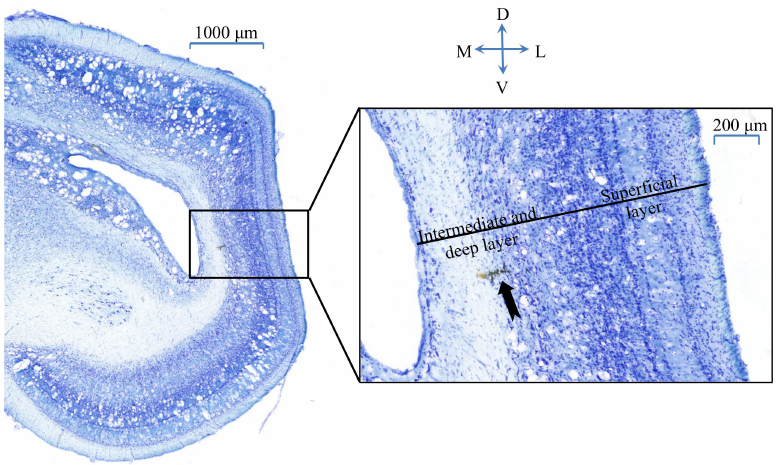
Figure 2. Representative photomicrograph of Nissl-stained coronal section showing the recording site of a sample unit. The right panel showed an enlarged view of the boxed area in the left panel. The black arrow pointed to the recording site. M—Medial; L—Lateral; D—Dorsal;